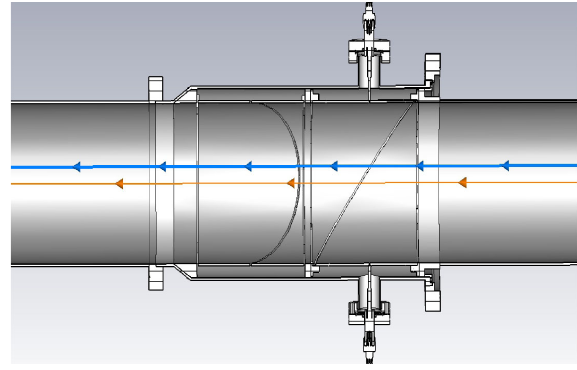
FIG. 8. Half of the 3D CST-model of BPM.